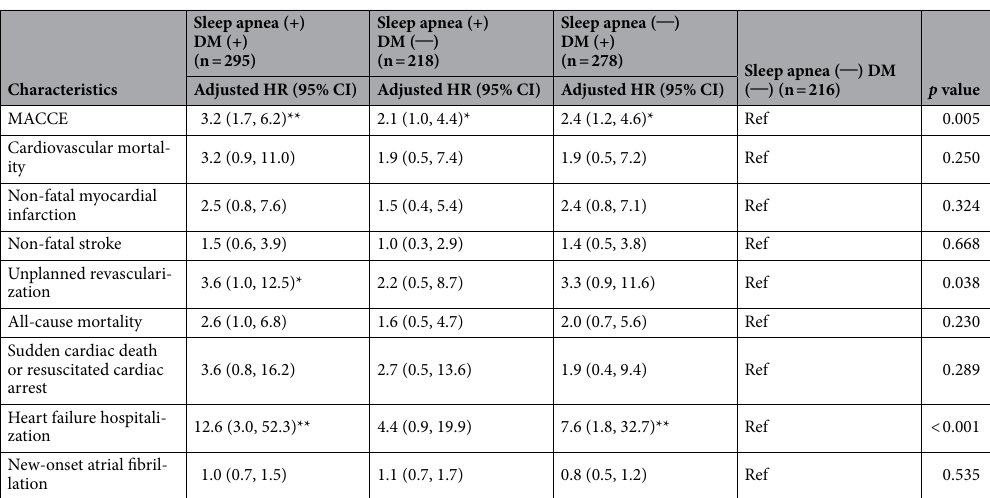
Table 5. Adjusted hazard ratios for adverse cardiovascular events via Cox regression. Age, sex, body mass index, left ventricular ejection fraction, hypertension, and chronic kidney disease were included as covariates and backward selection method was then applied. DM diabetes mellitus, MACCE major adverse cardiac and cerebrovascular events, CI confidence interval, HR hazard ratio. * p < 0.05; ** p < 0.01.